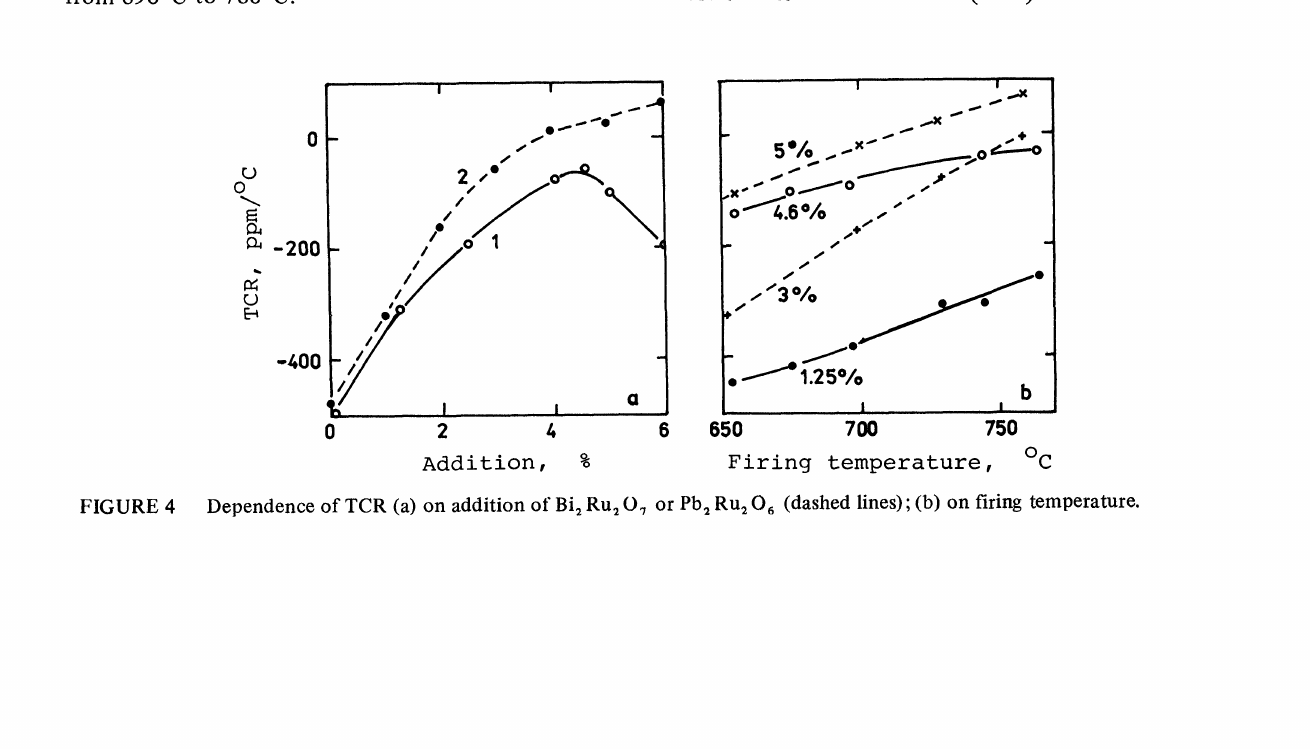
FIGURE 3 Sheet resistance as a function of firing tem- perature (1) 80% EV 6 + 20% CdO; (2) 70% EV 6 + 30% CdO.